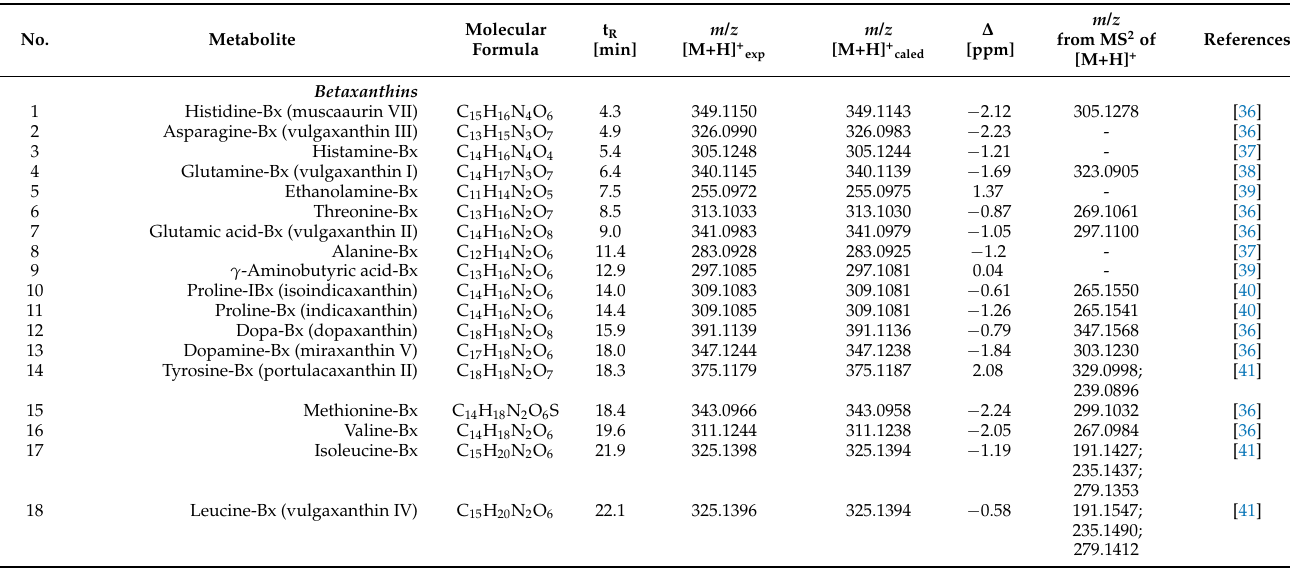
Table 2. High-resolution mass spectrometric data obtained by HPLC-DAD-ESI-HRMS/MS analysis of metabolites in the flowers of yellow, orange, red and purple P. grandiflora , analysed in negative and positive ionization